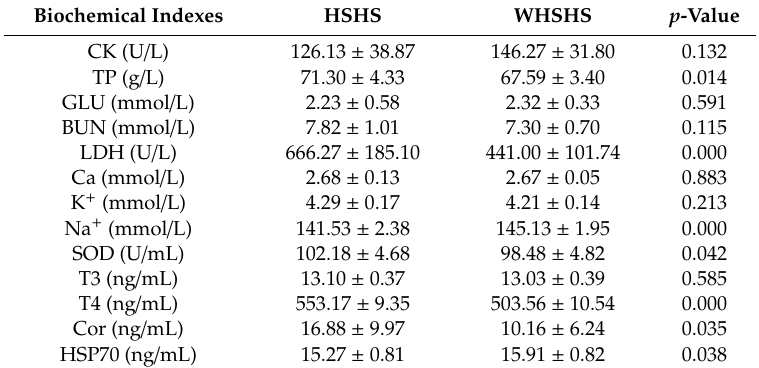
Table 1. Comparison of the blood biochemical indexes between HSHS and WHSHS.